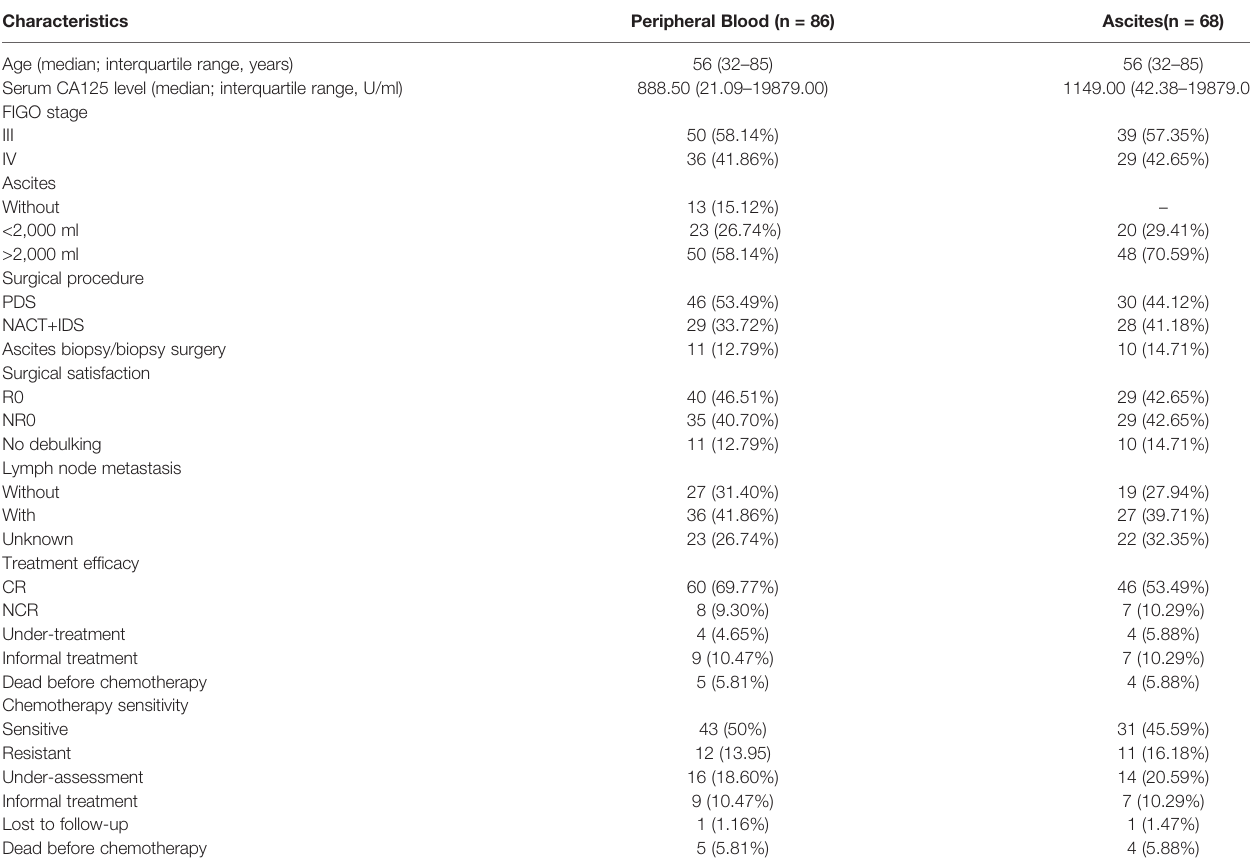
TABLE 1 | Demographic characteristics and clinical parameters of study population.